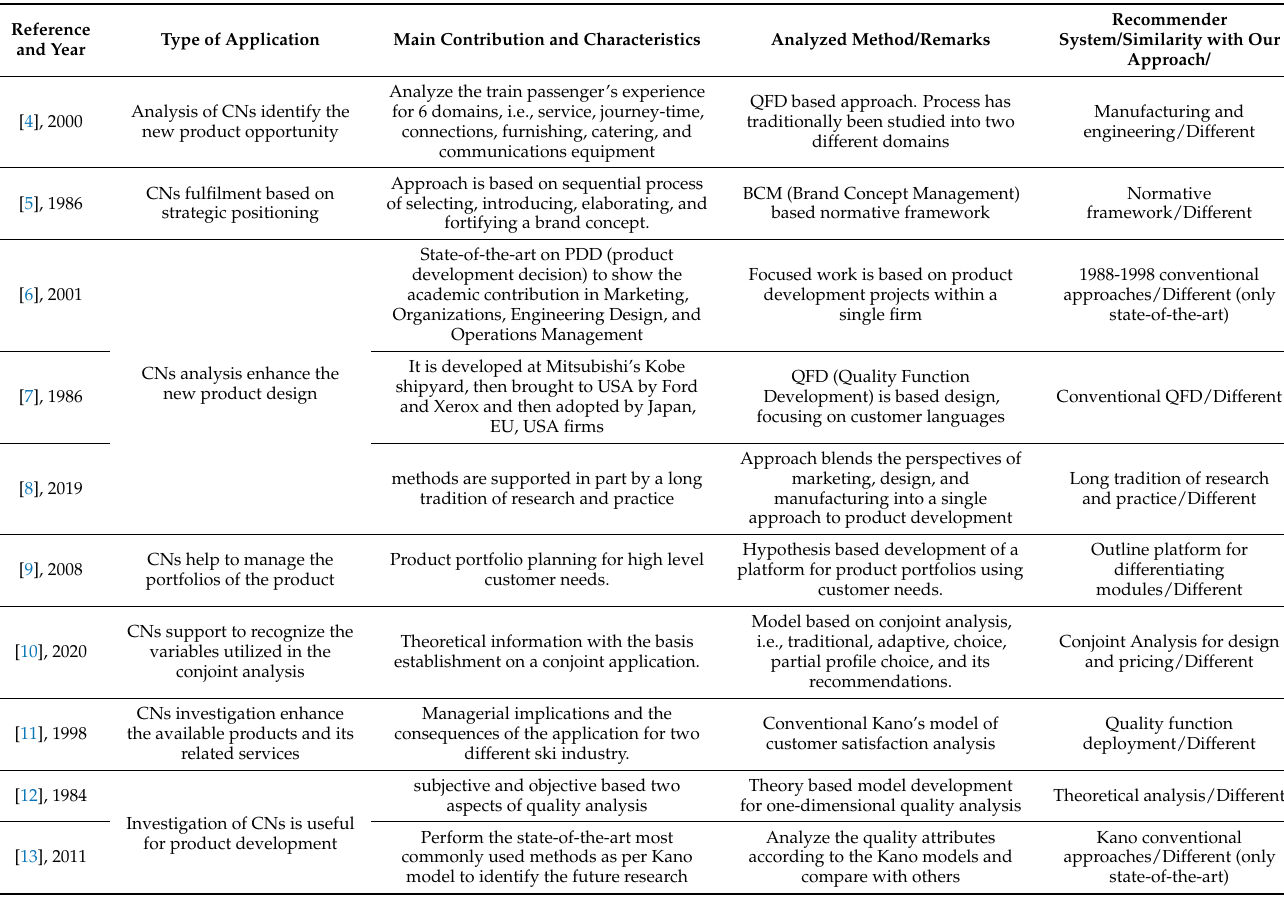
Table 1. Summary of work related to CNs need analysis for different market product analysis point of view (such as product opportunity, strategic analysis, product design, management of portfolios, attribute identification, services management, etc.) in a general